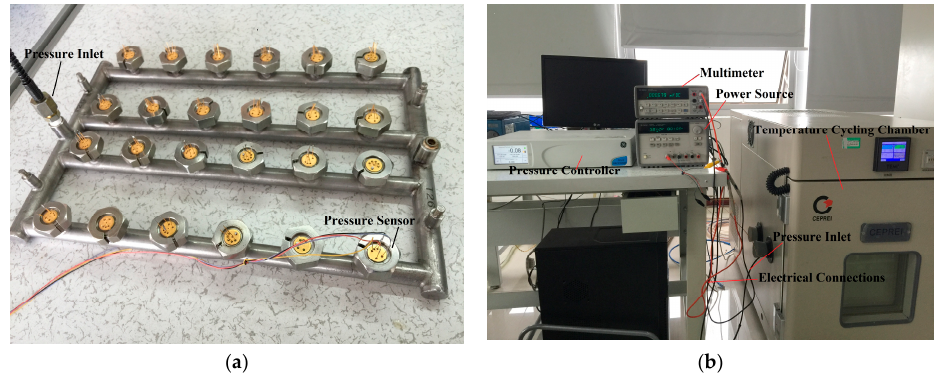
Table 2. Resistance of the piezoresistors vs. gate voltage.